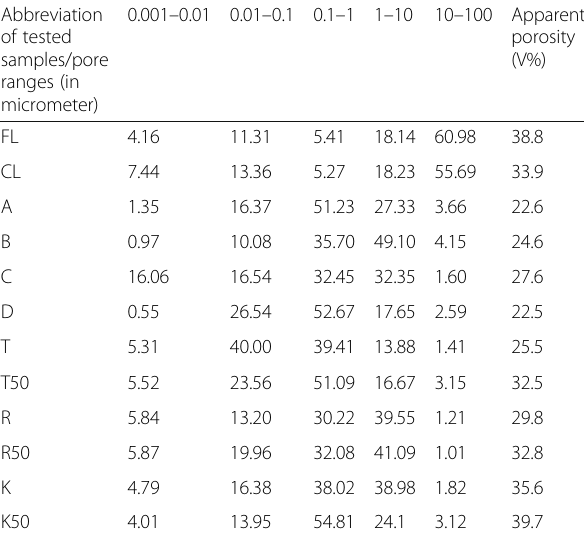
Table 2 Pore-size distribution and apparent porosity of stone and mortar Abbreviation of